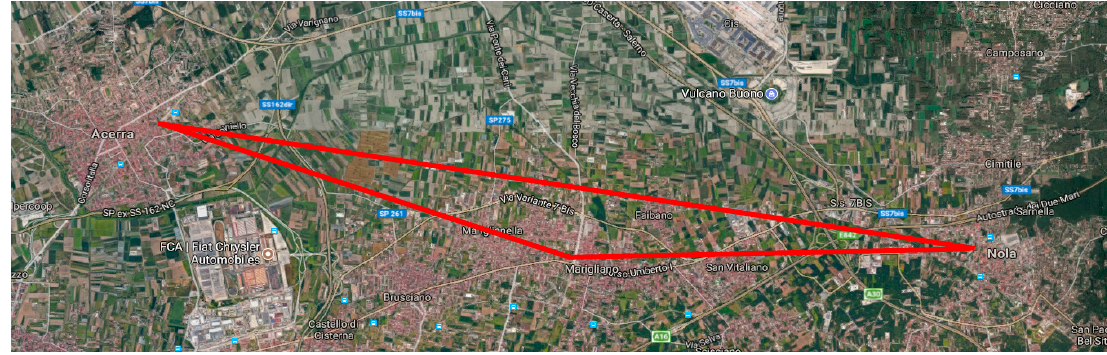
Figure 1. Map of the “ triangle of death ” (Scale 1:100,000).